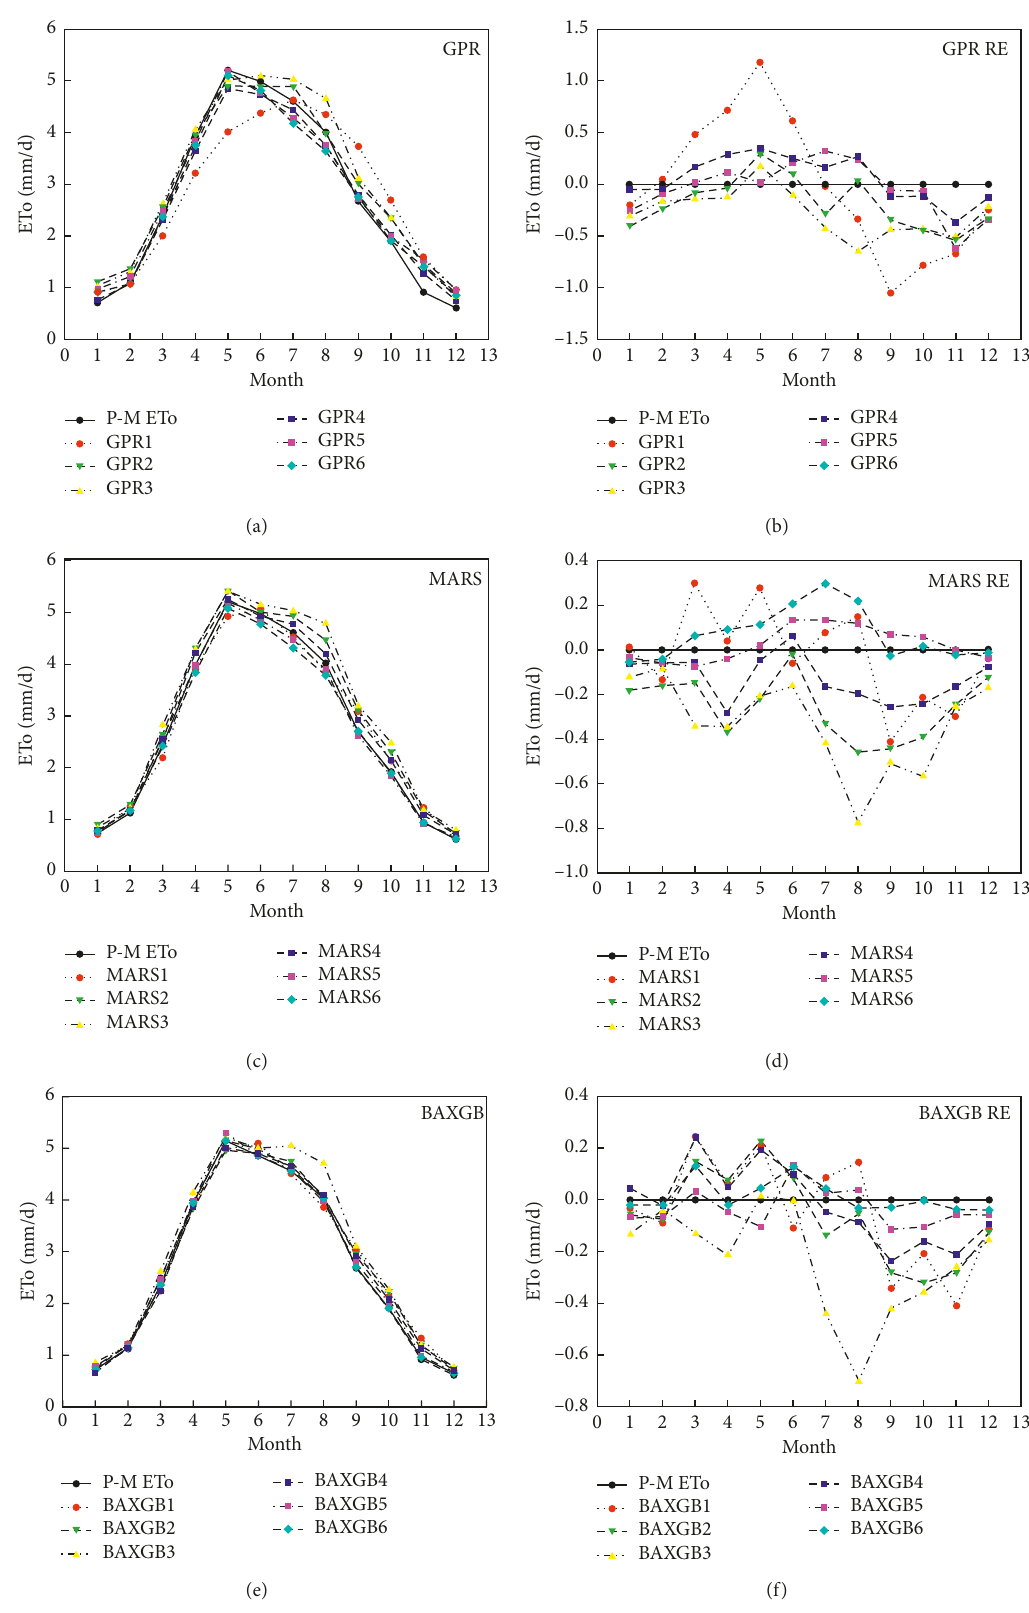
Figure 5: Relative errors by the different algorithms at each month for the Datong